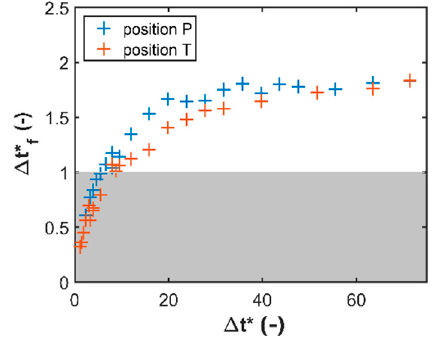
Figure 11. Dependence of Δ 𝑡 ∗ f on Δ 𝑡 ∗ .